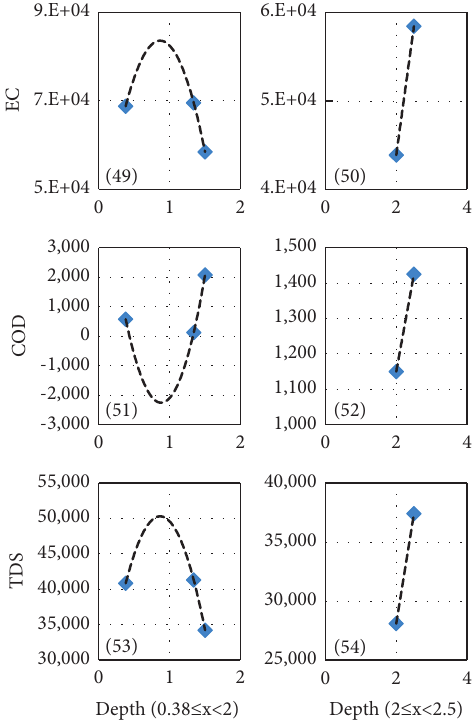
Figure 12: Estimation of the regressions of EC, COD, and TDS for the second two intervals in depth. Table 4: Estimated values of water elements at different depths of the lake.